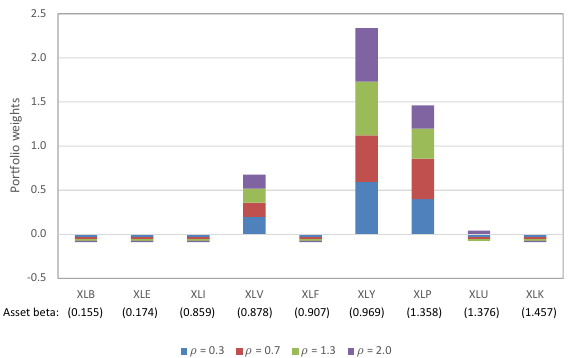
Figure 9. Portfolio allocation on assets with high beta as leverage restrictions are